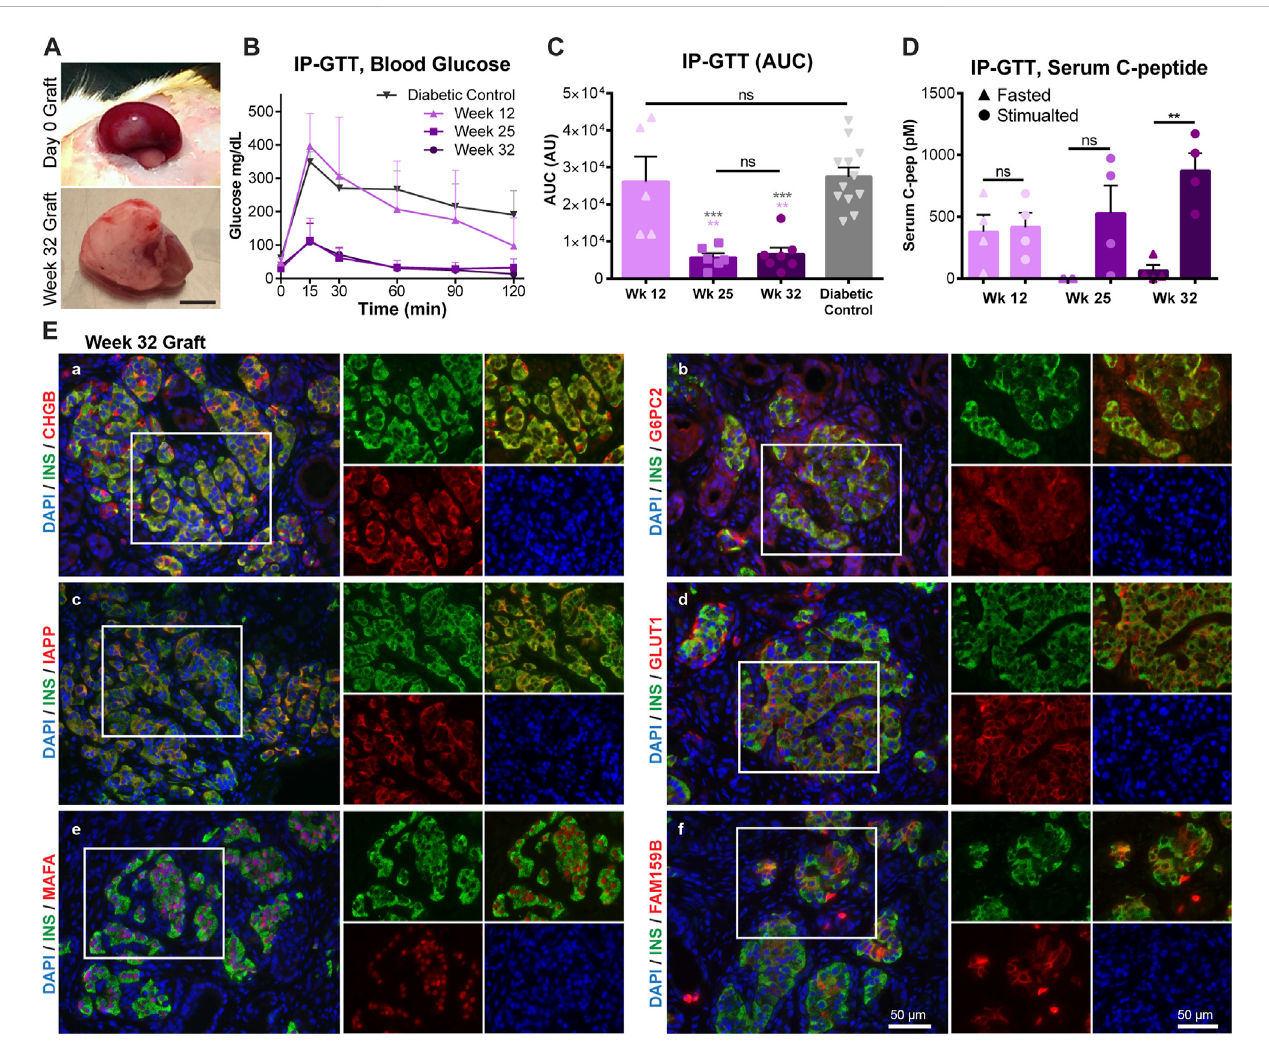
FIGURE 6 Human fetal pancreas functional maturation corresponds with increased maturation marker expression. Transplanted HFP was monitored for in vivo function through IP-GTT. (A) Representative images of the graft on the day of transplantation (Day 0 Graft) and after 32 weeks. Scale = 0.5 cm. (B) Blood glucose values during IP-GTT at 12, 25, and 32 weeks post-transplantation compared to diabetic non-transplanted controls. (C) Area under the curve (AUC) values for the IP-GTT curves. Gray asterisks indicate statistical comparison to the diabetic control, while light purple asterisks indicate statistical comparison to Week 12. (D) Serum human C-peptide levels in fasted and stimulated (15 min after glucose injection) states. (E) Representative images of immuno fl uorescent staining of 32 weeks grafts for maturation markers (in red) CHGB (a), G6PC2 (b), IAPP (c), GLUT1 (d), MAFA (e), FAM159B (f). Scale = 50 microns. (ns = not signi fi cant, ** p < 0.01, *** p <